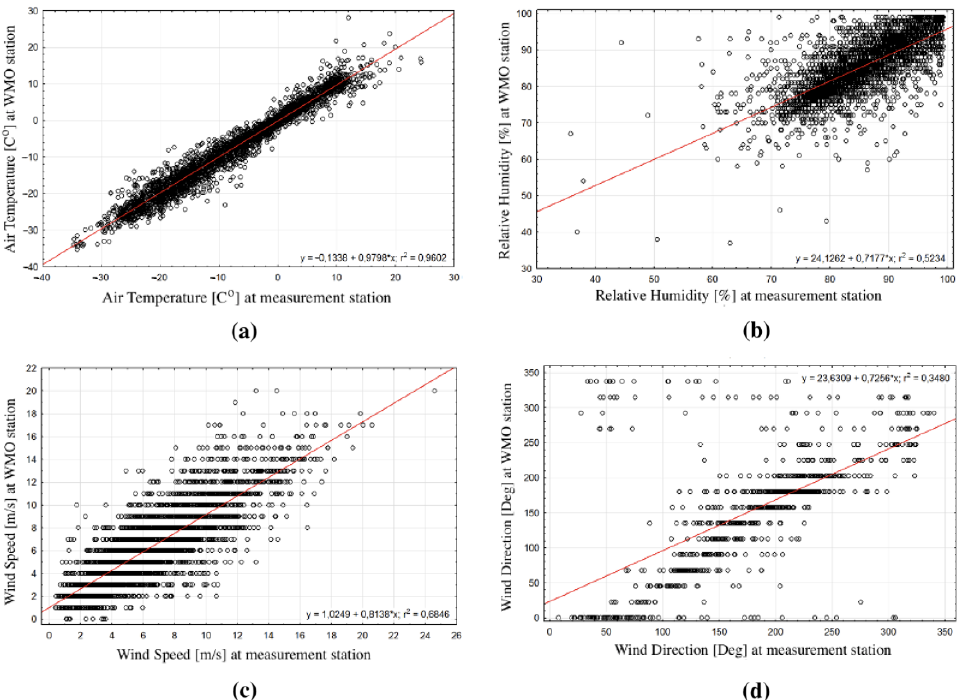
Figure 7. Linear regression analysis for the two data sets of meteorological records at the measurement station “DIAMIS” and the weather station “The Island of Dikson” (WMO ID: 20647): air temperature ( a ), relative humidity ( b ), wind speed ( c ), and direction ( d ) for the period of observations (September 2018 – February 2020). Linear trends and the determination coefficients are shown.